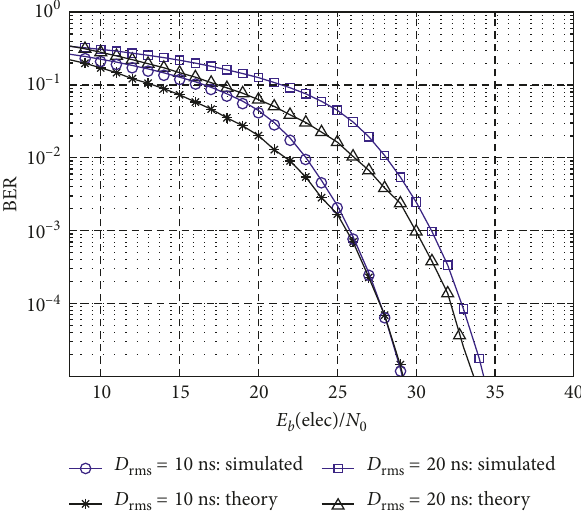
Figure 7: Theoretical and simulated BER of STACO-OFDM for spectral efficiency of